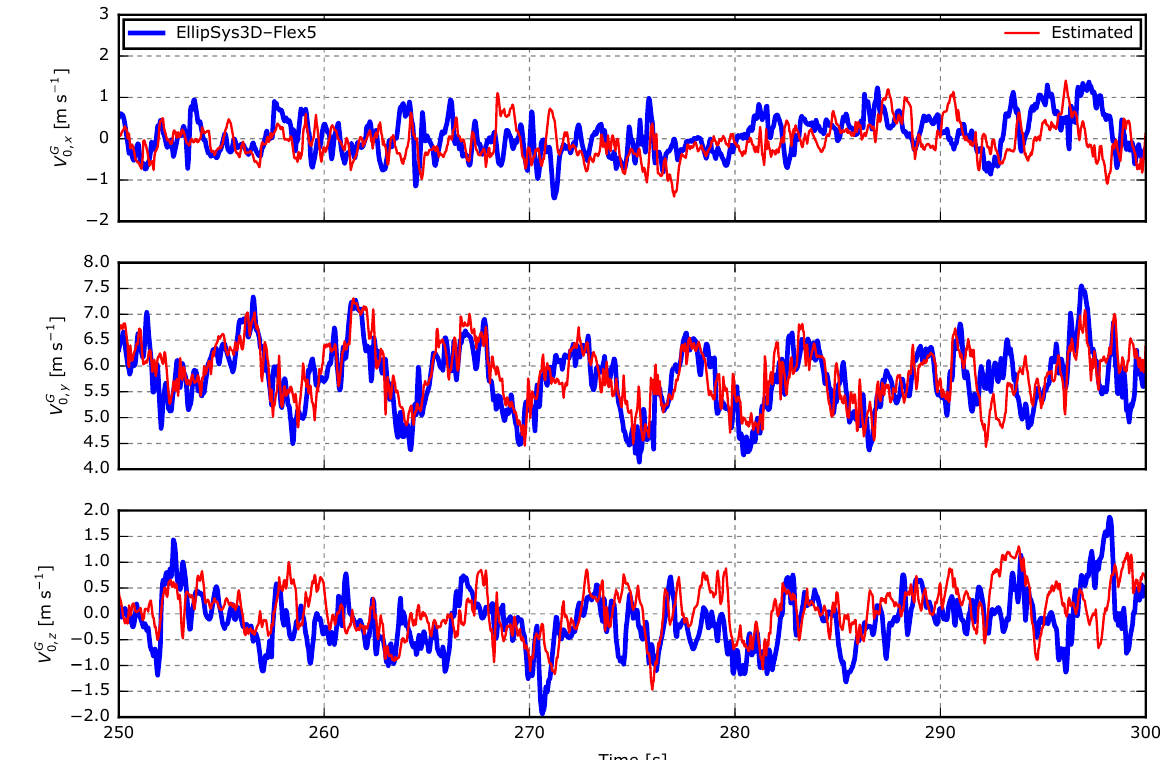
Figure 18. EllipSys3D–Flex5 results including the free wind speed estimated in velocity based on turbulent inflow (7ms − 1 ) in blade-section coordinates (Case